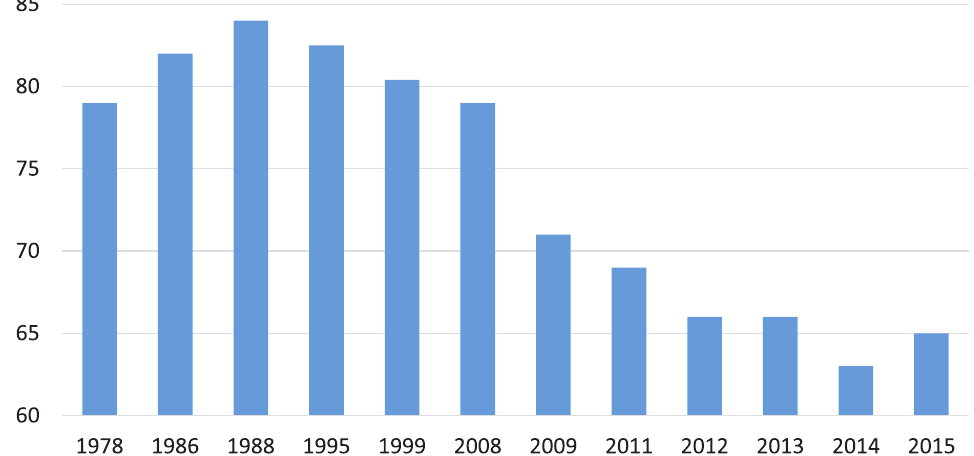
Figure 4. Ratio of women’s income to men’s income: China 1978–2015. Due to different sources of data, the gender wage gap differs. Sources: Data from 2008–2015 from WEF (2019); other data compiled by the